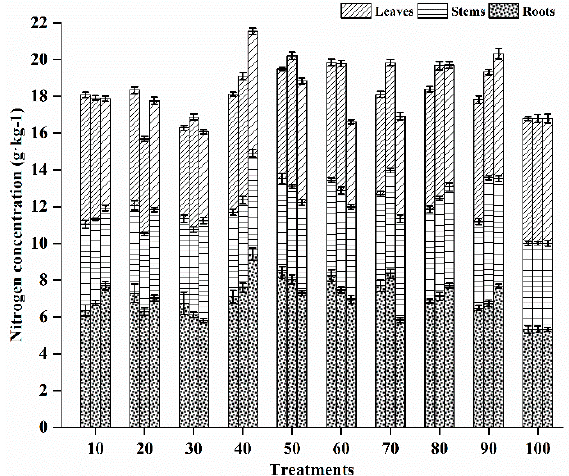
Figure 5. The nitrogen distribution in different vegetative tissues (Note: There are three linked bars: four fertilizer applications on the left, six fertilizer applications in the middle, and eight fertilizer applications on the right).